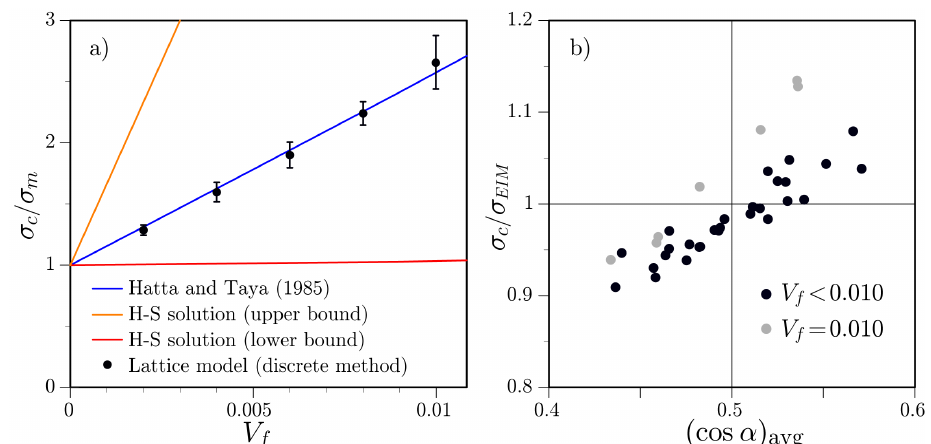
Figure 8. ( a ) Composite conductivity values based on discrete (volumetric) fiber models. Seven nominally identical, randomly generated models were tested for each V f value; and ( b ) dependence of simulated conductivity measurements on the orientation of fibers with respect to the direction of the electric